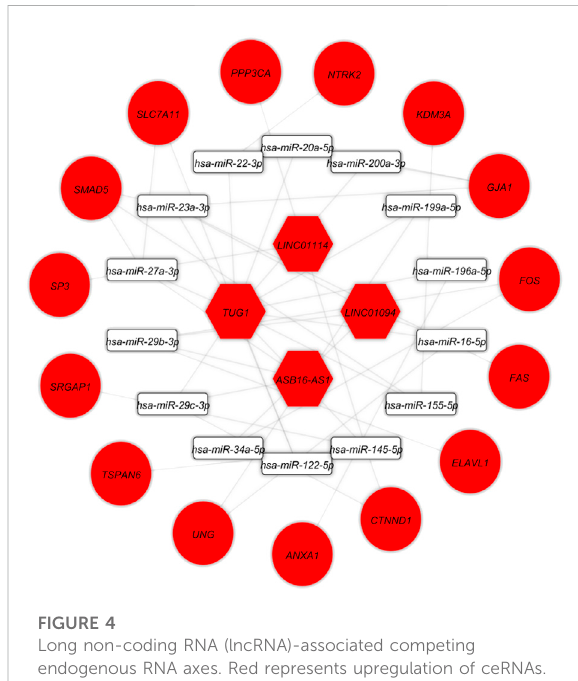
FIGURE 4 Long non-coding RNA (lncRNA)-associated competing endogenous RNA axes. Red represents upregulation of ceRNAs. LncRNAs,miRNAs,andmRNAsarerepresentedbyhexagon,round rectangle, and ellipse,